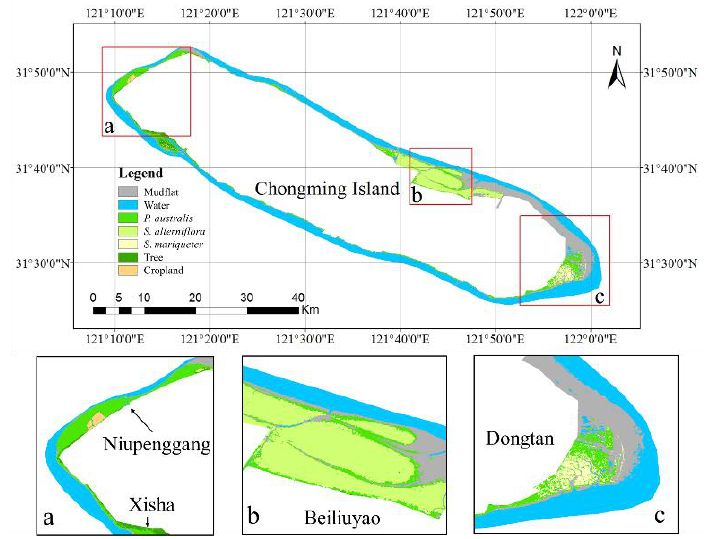
Figure 9. The classification of the senescence period under the proper feature combination. Subfigure ( a ) shows the Xisha and Niupenggang areas, subfigure ( b ) shows the Beiliuyao area, and subfigure ( c ) shows the Dongtan area.